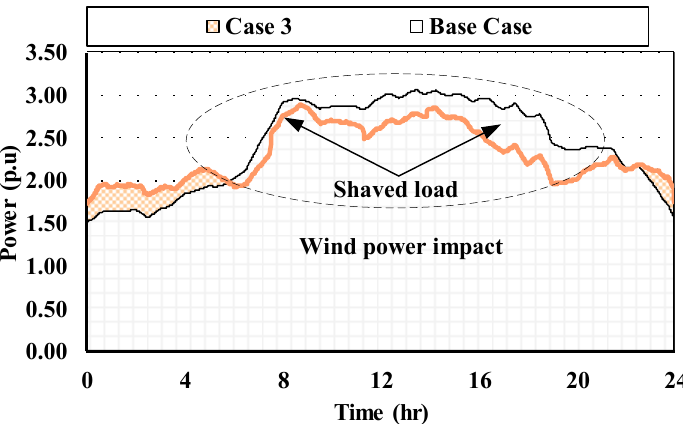
Figure 15. Total load with wind and controlled EVs charging (Case 3).